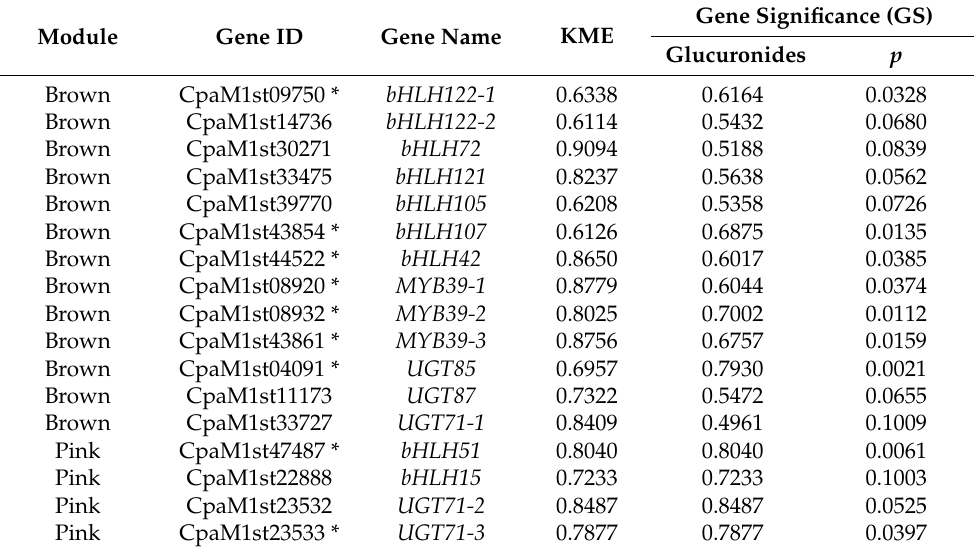
Table 1. List of member genes in the WGCNA module; “brown” and “pink” are highly associated with glucuronide content.